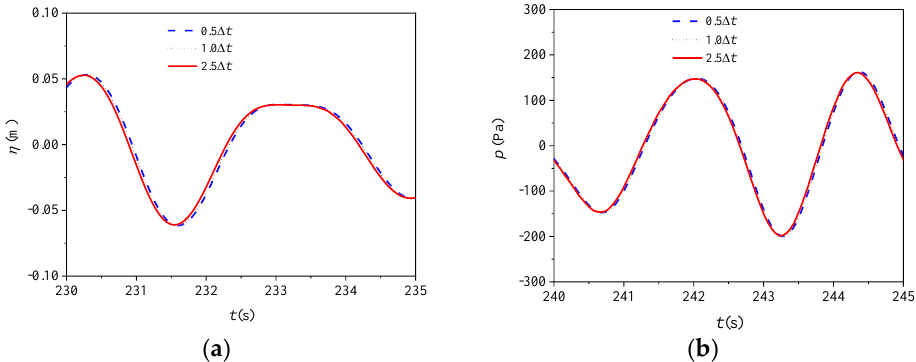
Figure 4. Time histories of the ( a ) free surface elevations at chamber center and ( b ) pneumatic pres- sures in the chamber for different temporal step intervals.